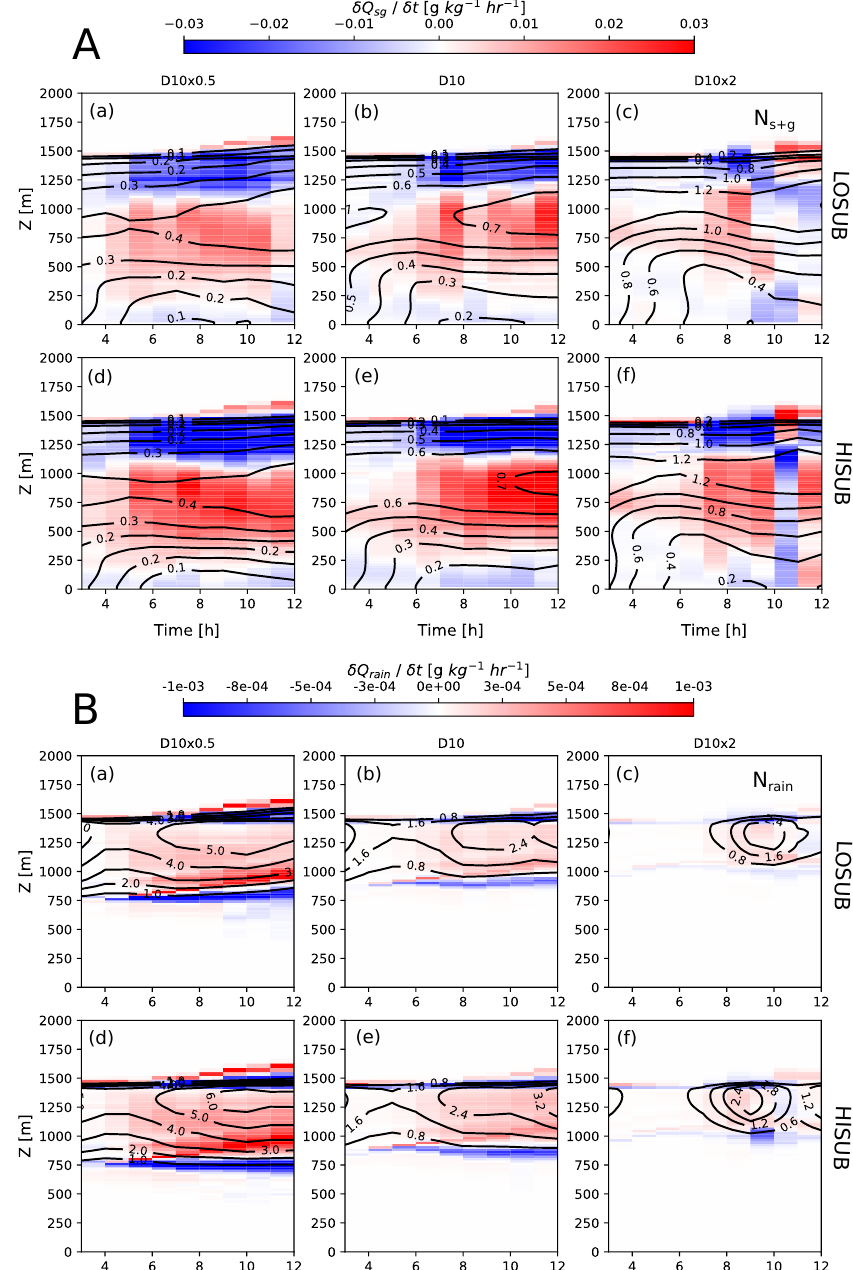
Figure 7. As Fig. 5, but instead the ice number concentration is varied (test